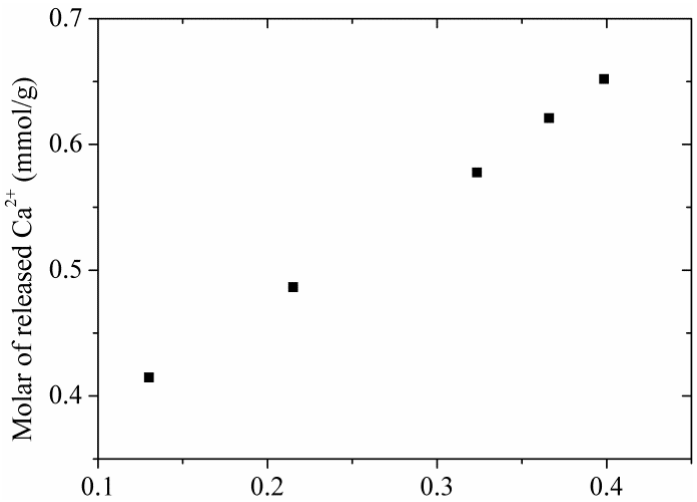
Figure 11. The amounts of Ca 2+ released from tobermorite at different adsorption amounts of Cr(VI).